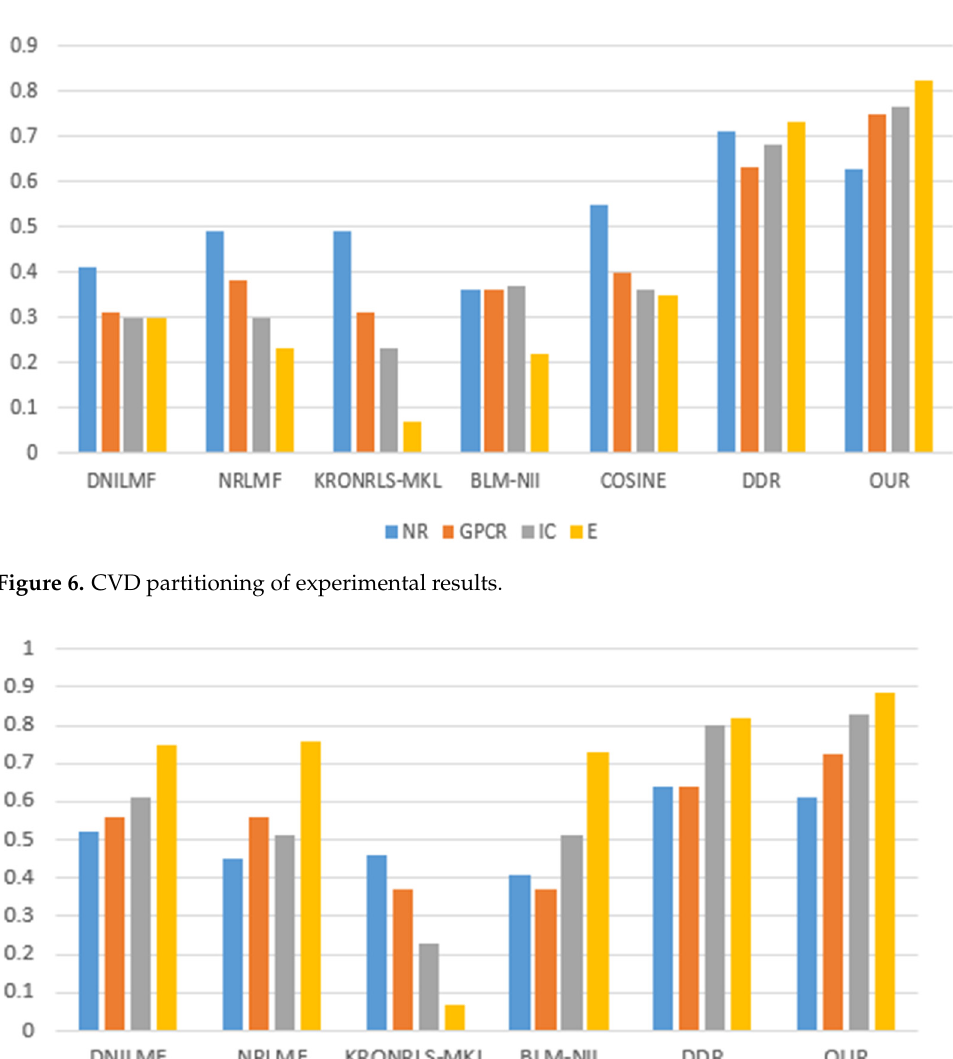
9 of 16 Figure 5. AUC curve of the enzyme dataset under CVT division.